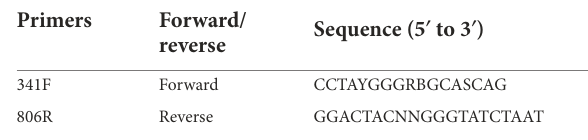
TABLE 2 Primer sequences for 16S